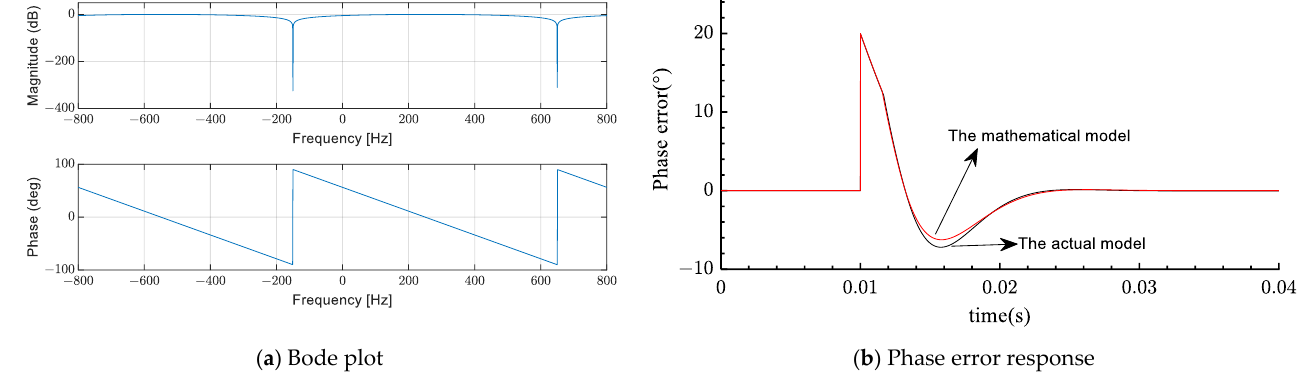
Figure 7. ( a ) Bode plot of the MDSC operator with n = 16.; ( b ) Accuracy assessment of the mathematical model of the proposed PLL with n = 16.